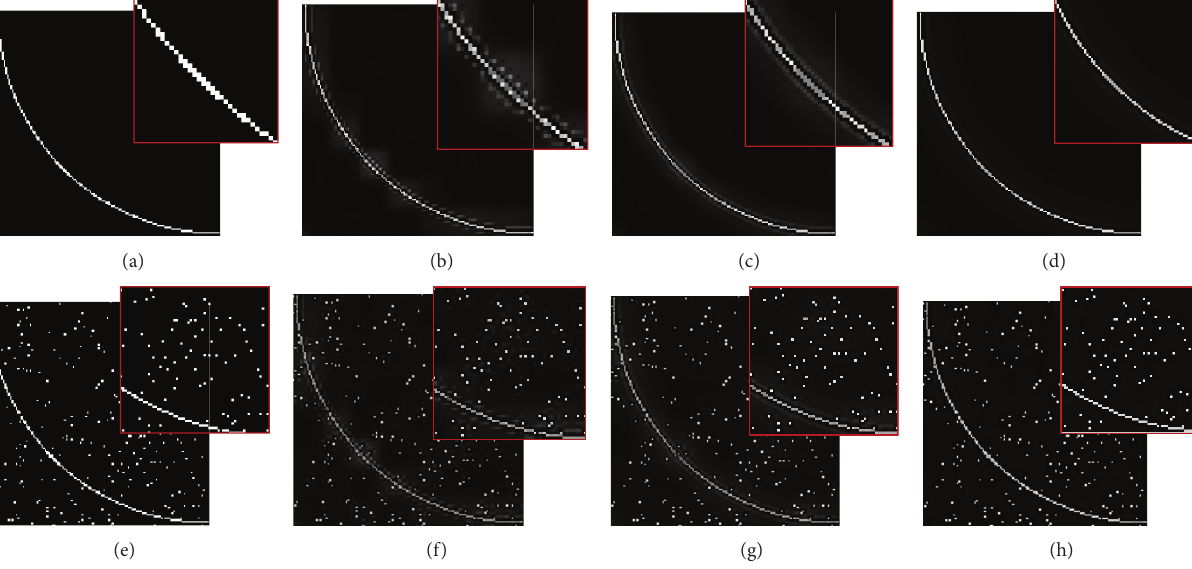
Figure 3: Improved directionality of complex double-density dual-tree wavelet transform: (a) original test image; reconstructed image using only the lowest level coefficients of (b) DWT; (c) DT-CWT; (d) CDDDT-DWT; (e)–(h) results of the same experiment with noisy image (zoomed-in at the right corner). Gray level is normalized between [0, 1] for all images and 4-level transform is used for all